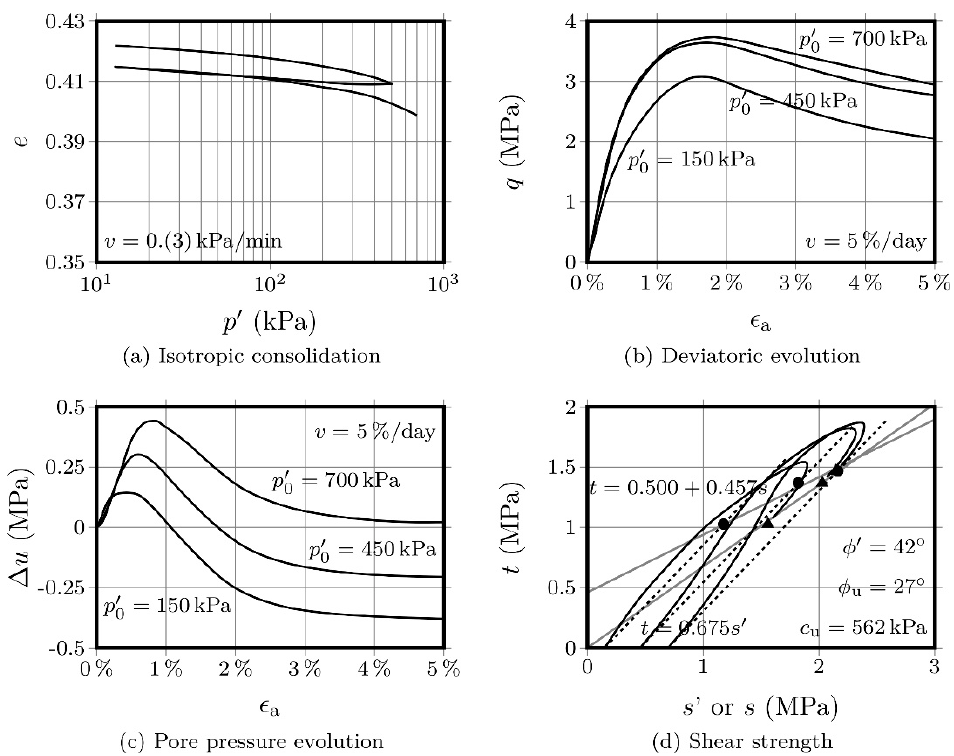
Figure 7. CIU triaxial tests performed on the AAC-S material after 90 days curing.